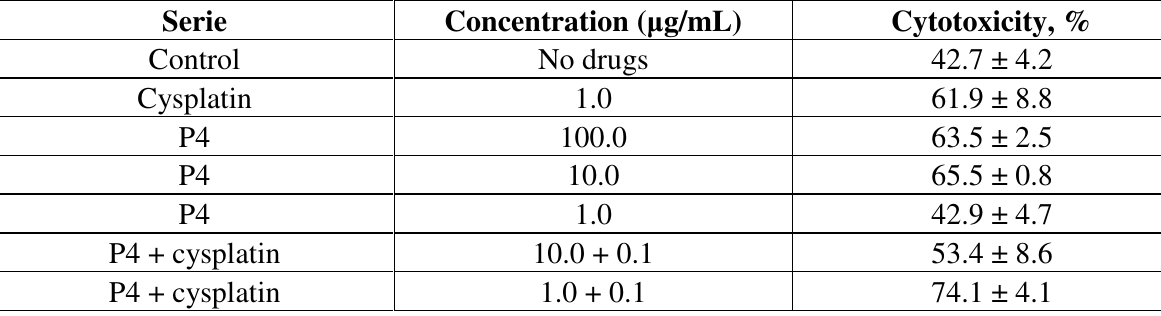
Table 1. The cytostatic effects of cisplatin and/or P4